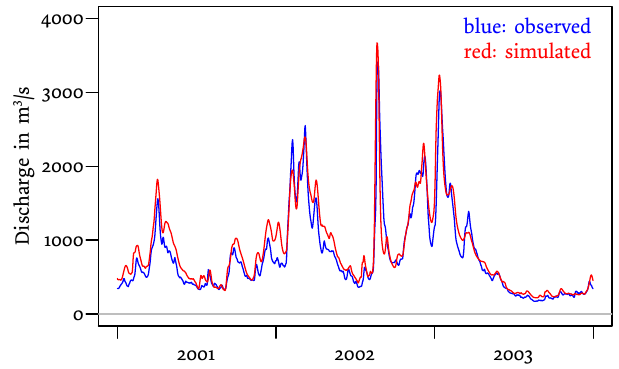
Fig. 4. Observed and SWIM-simulated hydrographs for the outlet gauge Neu